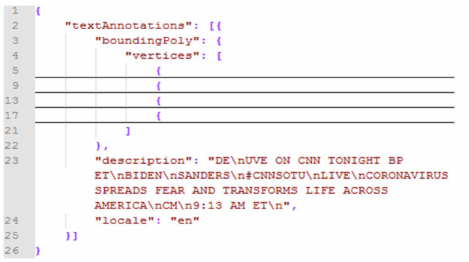
Figure 4. The extracted text of Figure 2 recognized by Google Cloud Vision